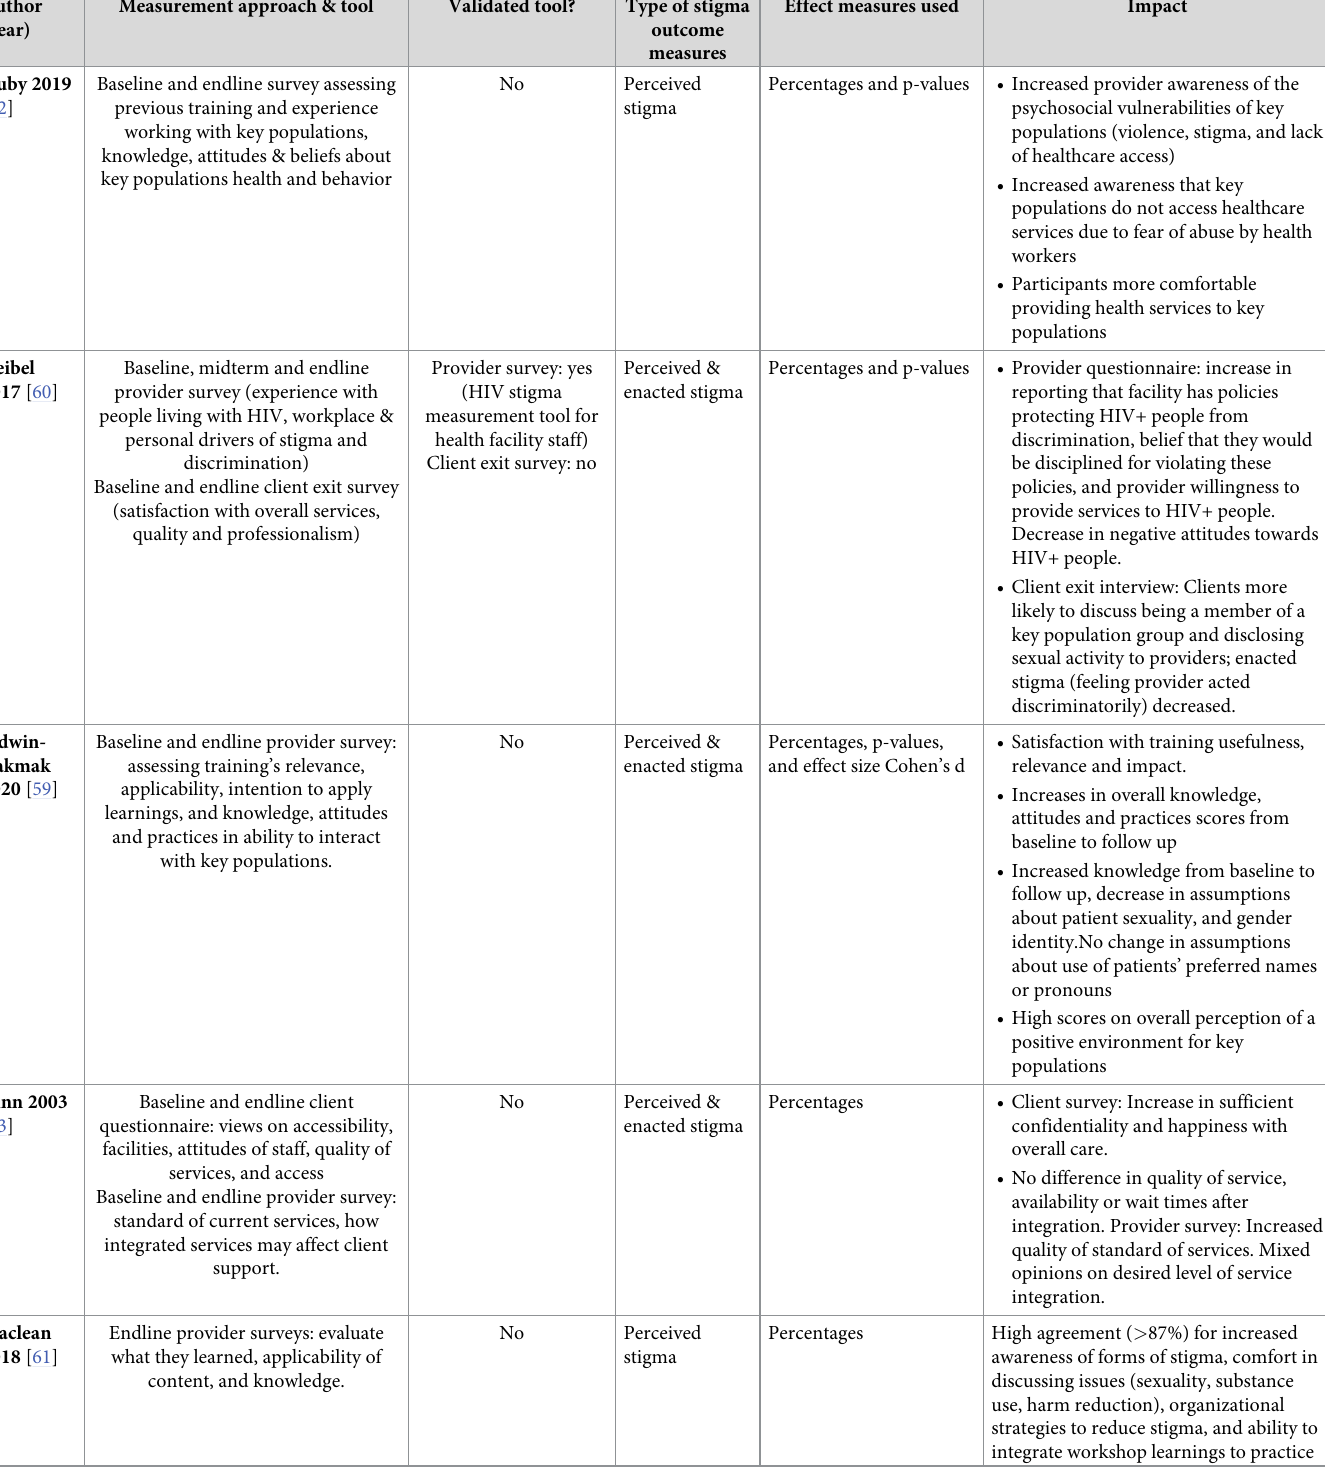
Table 2. Quantitative measurement approach outcome evaluation (among n = 9 studies with quantitative